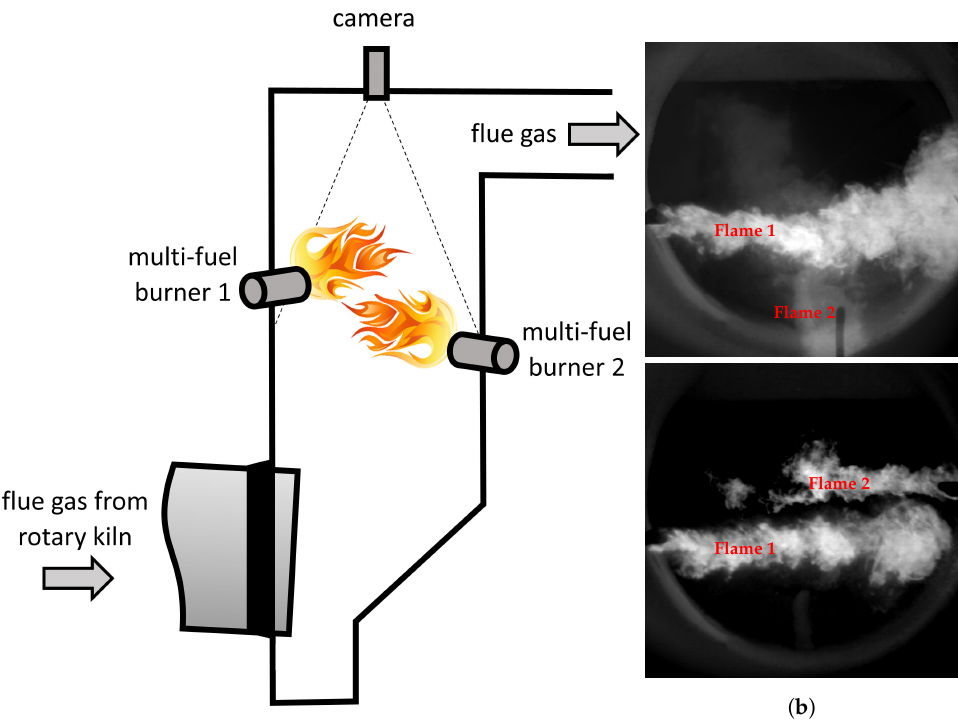
Figure 1. ( a ) Schematic of the afterburner chamber in a waste incineration plant. Gases are induced from a rotary kiln and pass through the chamber to the outlet at the top. The chamber is a vertical cylinder of about 2 m in diameter and several meters in height. At multiple positions burners are mounted horizontally in the chamber wall, producing characteristic flames. The process can be observed from top-view perspective by a camera ( b